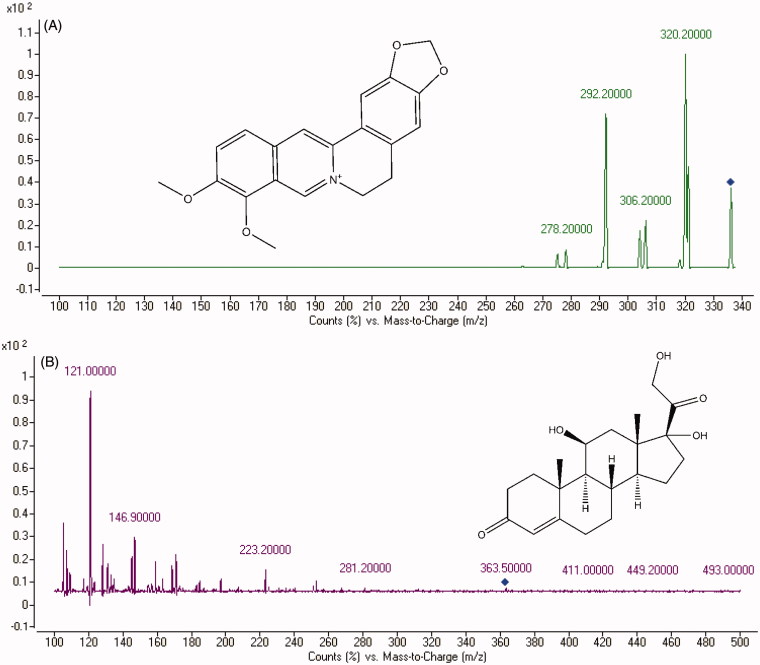
The mass spectra of (a) berberine (b) and IS.